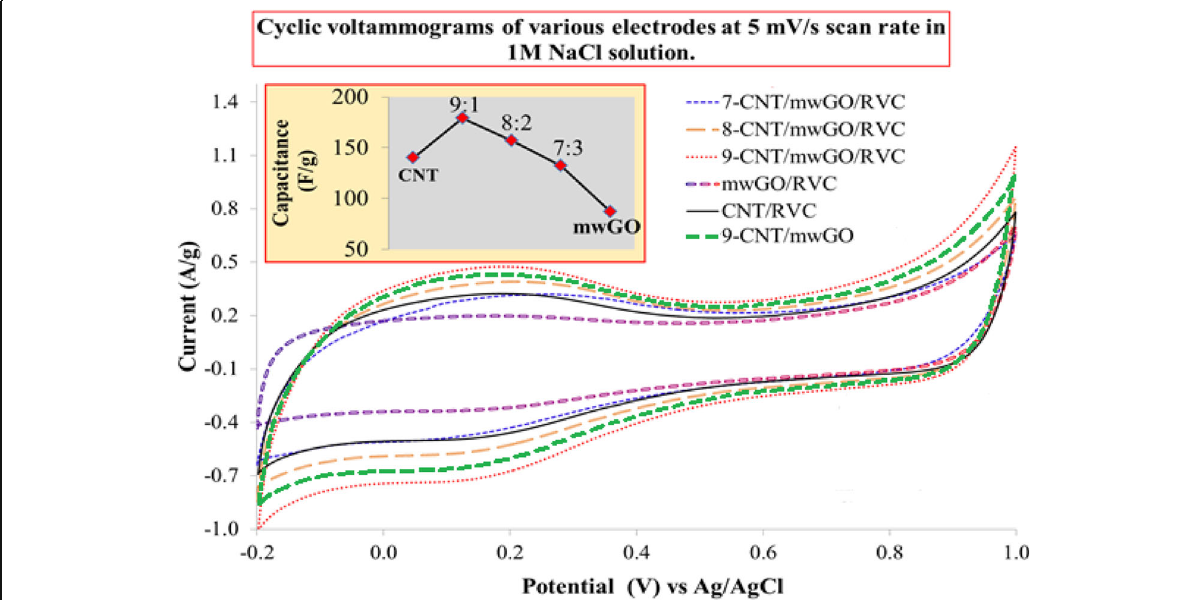
Fig. 2 Comparison of CVs and specific capacitance (inset) for mwGO/RVC, CNT/RVC, 9-CNT/mwGO, 7-CNT/mwGO/RVC, 8-CNT/mwGO/RVC, and